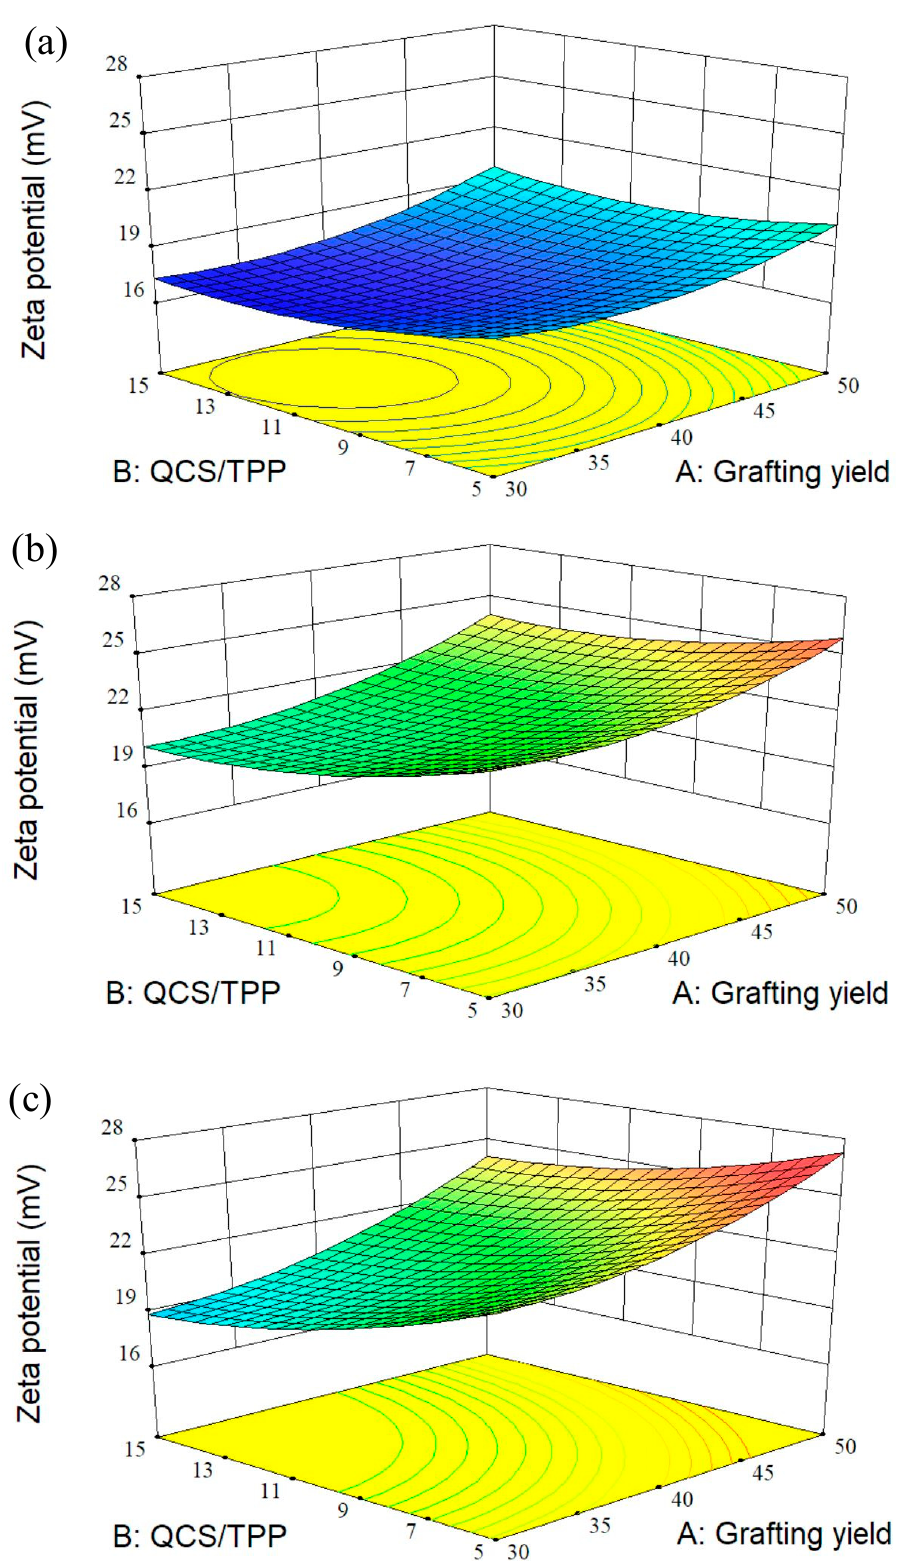
Figure 6. 3D response surface plots showing the effects of grafting yield and weight ratio of QCS/TPP at different weight ratios of QCS/genipin of ( a ) 20/1, ( b ) 40/1, and ( c ) 60/1 on zeta potential.